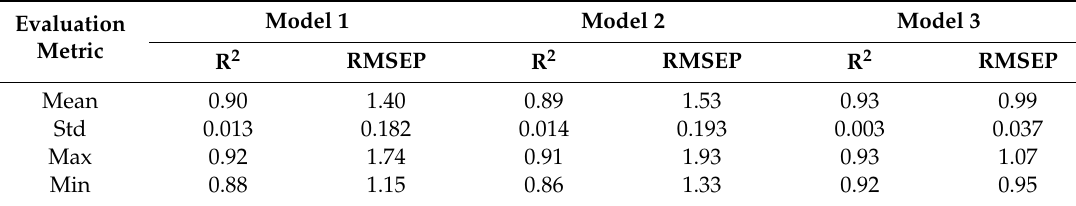
Table 4. Predictive results obtained by three CNNs based on raw data.